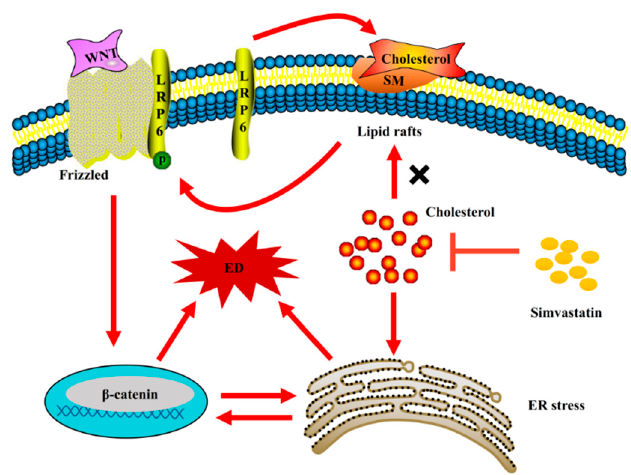
Figure 7. The mechanism of simvastatin in alleviating endothelial dysfunction under oxidative stress. LRP6 is localized to the cell membrane, and it is phosphorylated after it accumulates in the lipid raft which contributes to activate intracellular signal transduction in the Wnt / β -catenin pathway and then induce ER stress and endothelial dysfunction. Simvastatin can block intracellular cholesterol synthesis, which depresses endoplasmic reticulum stress and endothelial dysfunction, but does not further a ff ect the phosphorylation of LRP6 by a ff ecting lipid rafts. Therefore, although, simvastatin does not a ff ect transmembrane signal transduction in the Wnt / β -catenin pathway, but blocks intracellular signal transduction in the Wnt / β -catenin pathway by attenuating the ER